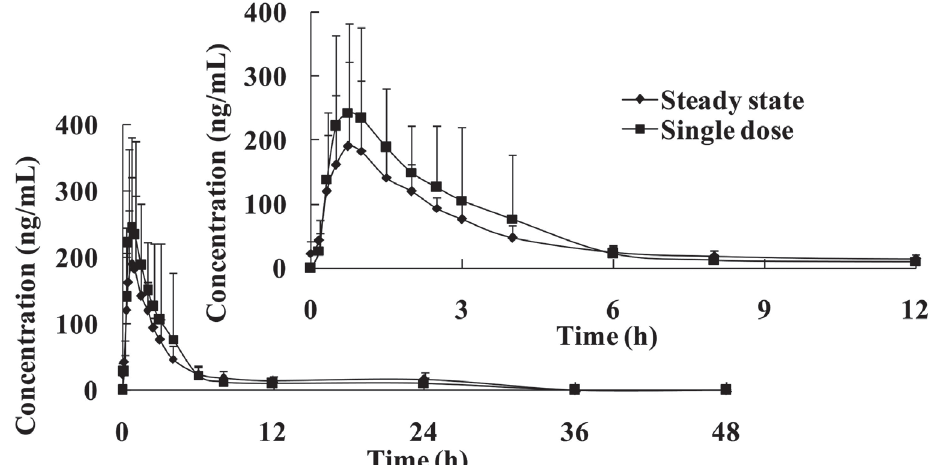
FIGURE 2 - Mean plasma concentration-time curves of MY-1250 in healthy Chinese subjects following multiple doses of 150 mg repirinast tablet every 12 h for 5 days (mean ± SD). TABLE IV - Main pharmacokinetic parameters of MY-1250 in healthy Chinese subjects following multiple doses of 150 mg